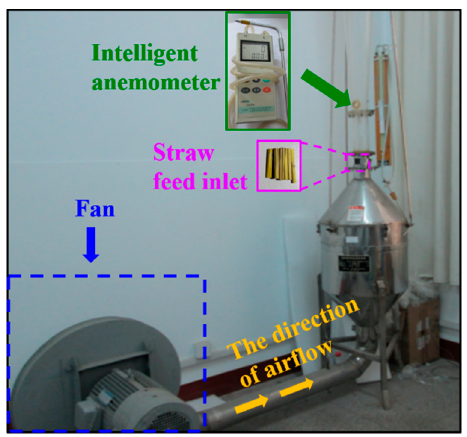
Figure 3. DFPF-25 suspension speed test device.